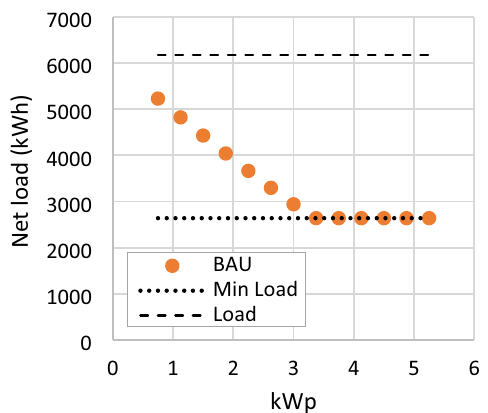
Figure 8. Net load of RSPP employing different numbers of PV modules in BAU scenario.